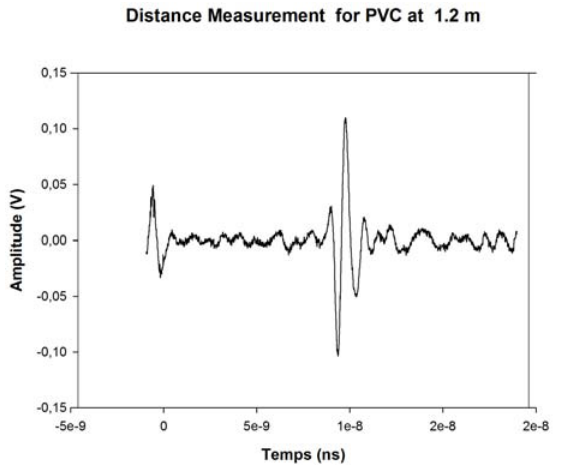
Figure 15: Time-domain response of the radar sensor mea- surement towards a PV C plate located at 120 cm .